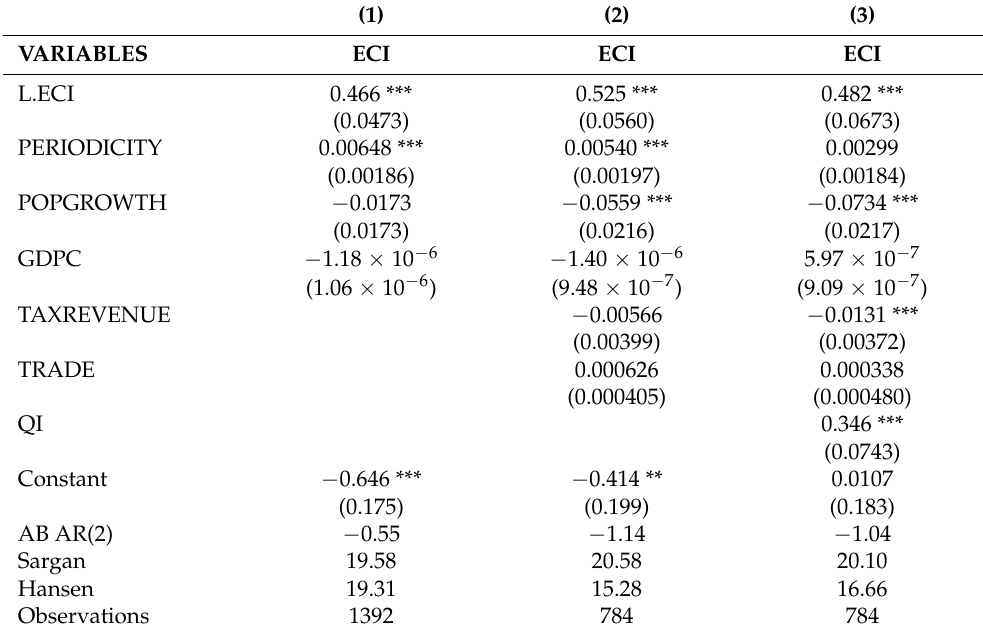
Table 5. Results of regression models (based on periodicity and timeliness assessment of statistical